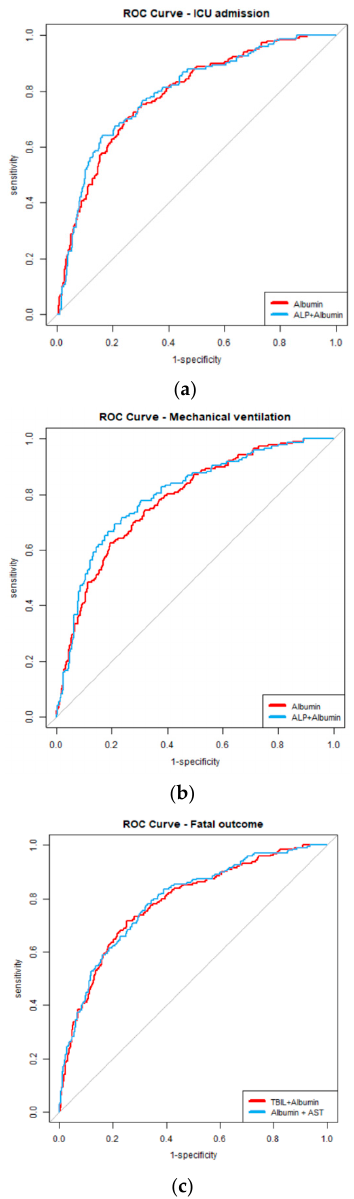
Figure 1. ROC curves presenting relationships between best models for endpoints ( a ) ICU admis- sion, ( b ) mechanical ventilation, and ( c ) fatal outcome. The models, apart from the laboratory parameters, were adjusted for hypertension, diabetes, asthma, COPD, dementia, stroke/TIA in patient history, chronic kidney disease, myocardial infarction in patient history, heart failure, leukemia, lymphoma and solid malignant disease, smoking history and length of hospital stay.